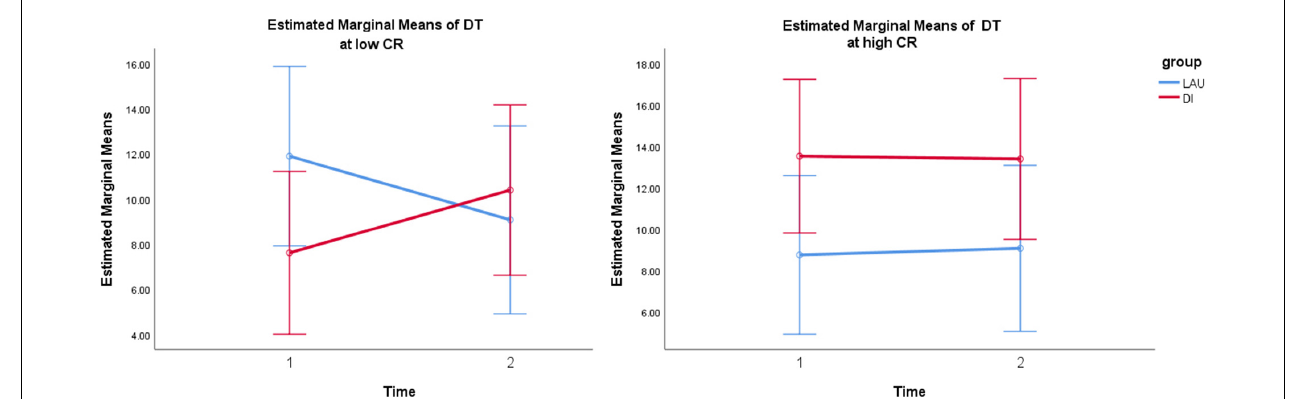
FIGURE 2 | Simple slope analysis of time*group interaction in low vs. high CR (based on median-split grouping) depicts significant interaction at lower values of CR. Error bars: 95% CI. Note: DT, dwell time; CR, cognitive reserve; LAU, life-as-usual; DI, dance intervention.